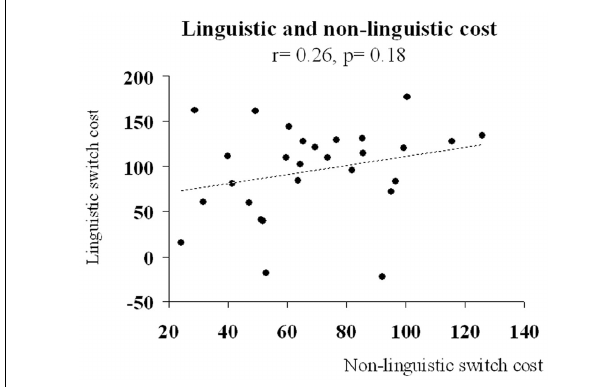
FIGURE 3 | Correlation of individuals’ performances between the linguistic and non-linguistic switching tasks, for Experiment 1 and Experiment 2 ( n = 28). In this graph we excluded one participant from Experiment 1 because his language switching cost was 2 SD above the group’s mean.